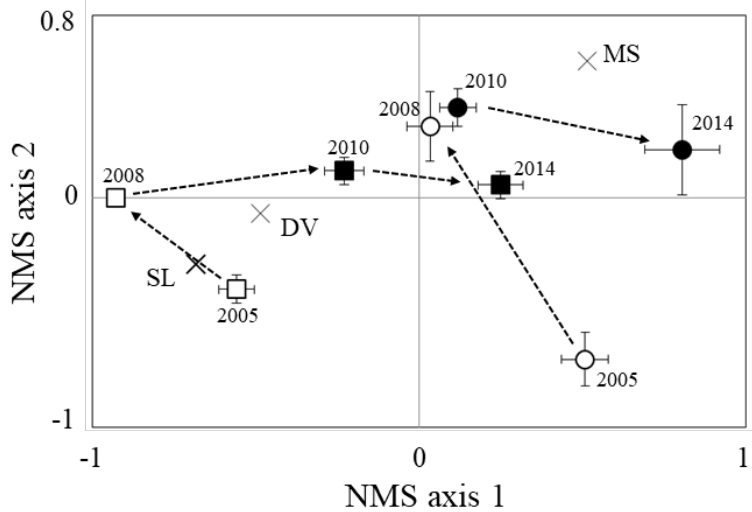
Figure 7. Nonmetric multidimensional scaling (NMS) ordination of fish assemblages showing the temporal changes in the downstream (circle) and upstream reaches (square) of the dam. Open and solid plots indicate before and after the dam removal, respectively, and they express the means with ± 1 standard errors for each axis. Numeric characters denote the survey years. Species are denoted by cross-marks with abbreviations: MS, masu salmon; DV, Dolly Varden; and SL, Siberian stone loach.